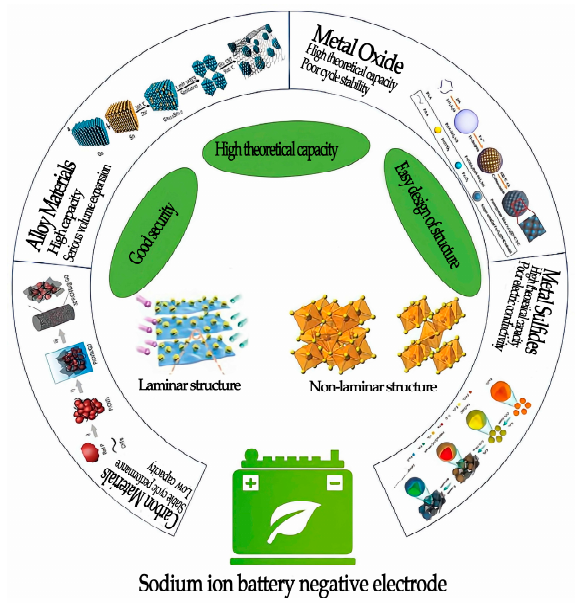
Figure 1. Anode materials for sodium-ion batteries (color online).